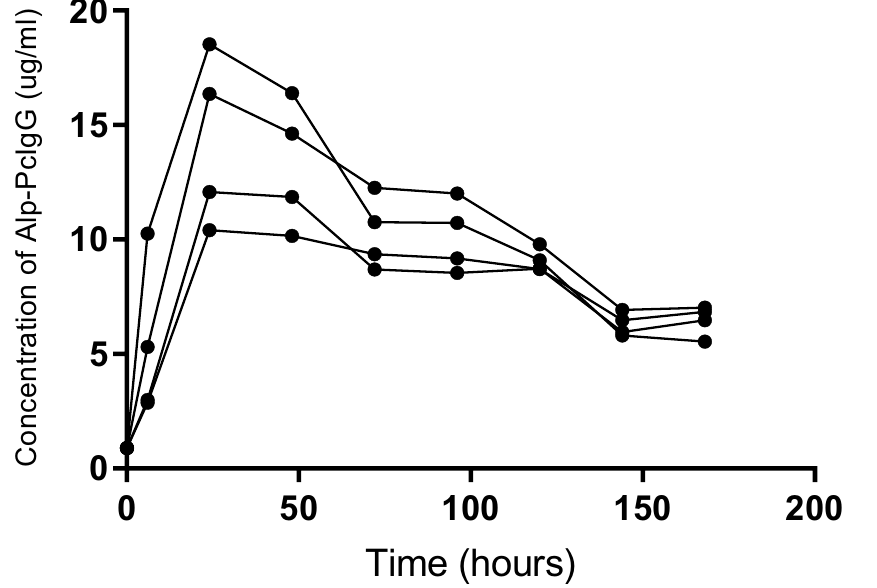
Figure 2. Bioavailability of Alp-PcIgG in Syrian hamsters. Four Syrian hamsters were administered 100 mg/ kg polyclonal alpaca IgG via subcutaneous injection and bled at 6, 24, 48, 72, 96, 120, 144, and 168 h post- treatment. Serum Alp-PcIgG levels were assessed by ELISA using a standard curve of naïve PcIgG of known